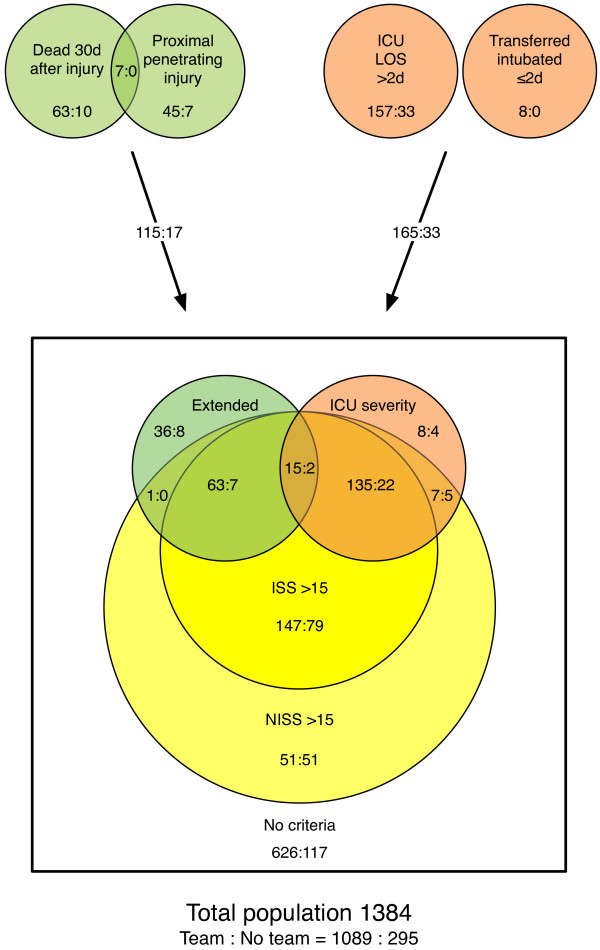
Set diagram of definitions for major trauma (circles); overlapping areas represent patients covered by two or more definitions. The “extensive” definition used in our study consisted of both “extended” and “ICU severity”. The number of patients triaged to be received by a trauma team is provided together with the number of patients not met by a team.